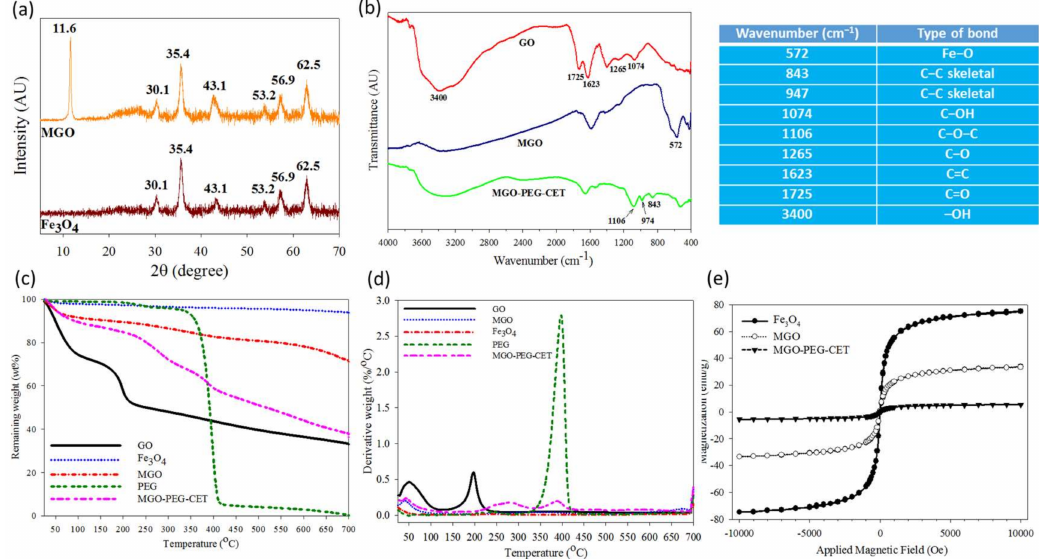
Figure 3. Characterization of MGO and MGO-PEG-CET by X-ray diffraction (XRD) ( a ); Fourier transform infrared (FTIR) ( b ); thermogravimetric analysis (TGA) ( c ); differential thermal analysis (DTA) ( d ); and superconducting quantum interference device (SQUID) ( e ). The table lists the wavenumbers of characteristic peak found in the FTIR spectra in ( b